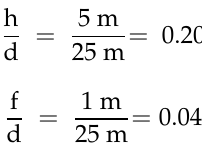
Figure 12. Diagram of the structure division into wind zones acc. [39].